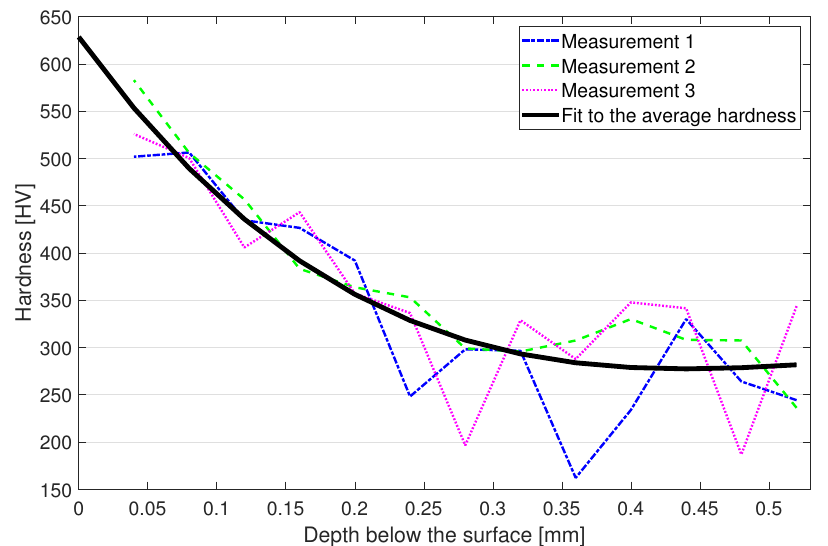
Figure 5. Hardness-depth profile of the heat treated and severe shot peened structure.